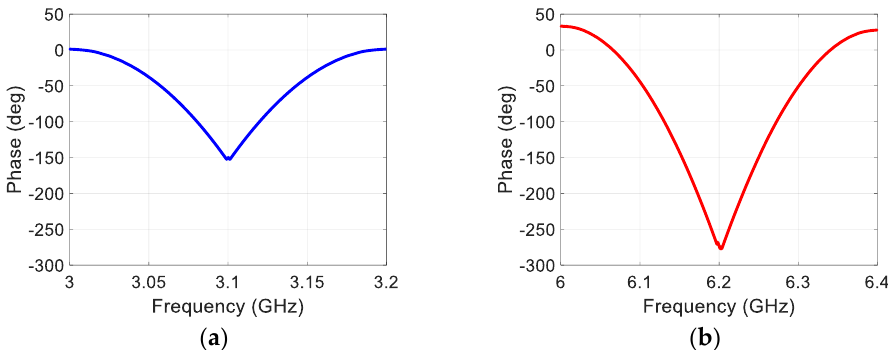
Figure 9. Phase plots of the ( a ) transmit and ( b ) receive (from the laptop) waveforms.